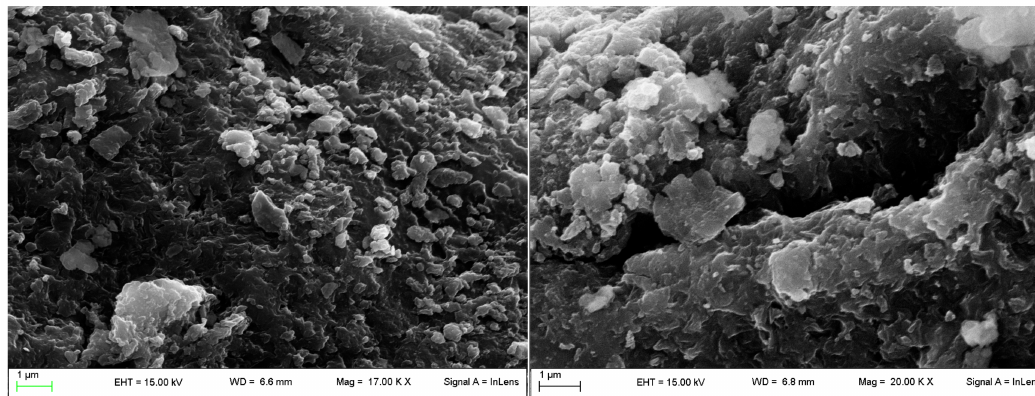
Figure 4. FE-SEM micrographs of ZrP-GTM.